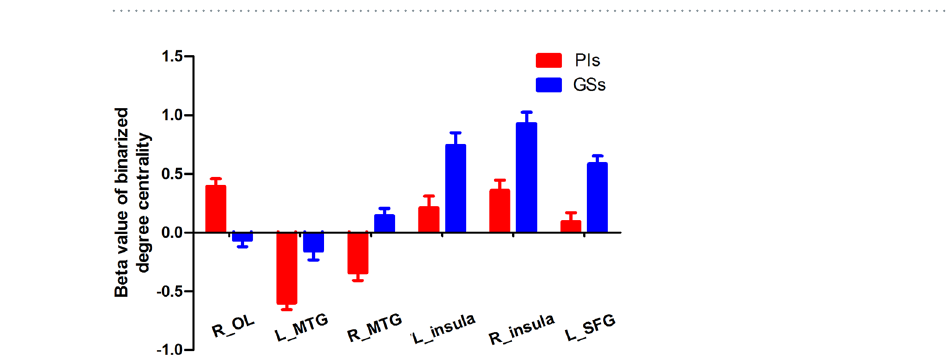
Figure 4. Between-group differences in binarized degree centralitynetwork with threshold at r = 0.25, and their correlations with behavioral performances in PIs. Abbreviations:R, right; L, left; SAS, Self-rating anxiety scale; PIs, Patients with primary